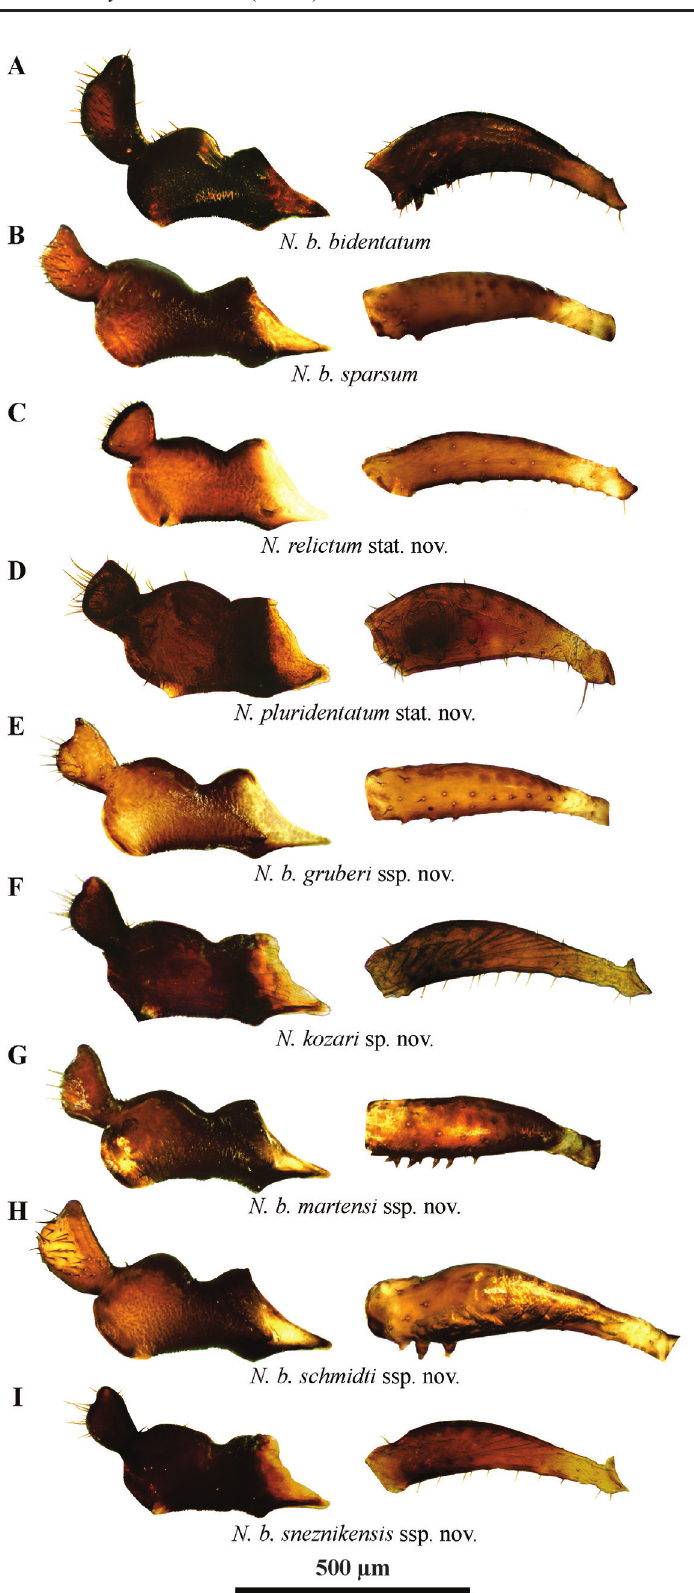
Fig. 6. Nemastoma bidentatum Roewer, 1914 complex, ♂♂. Synchroscopic images of the male Ch basal article and Pa-Fe (medial views, except G, right figure, which is in dorso-medial